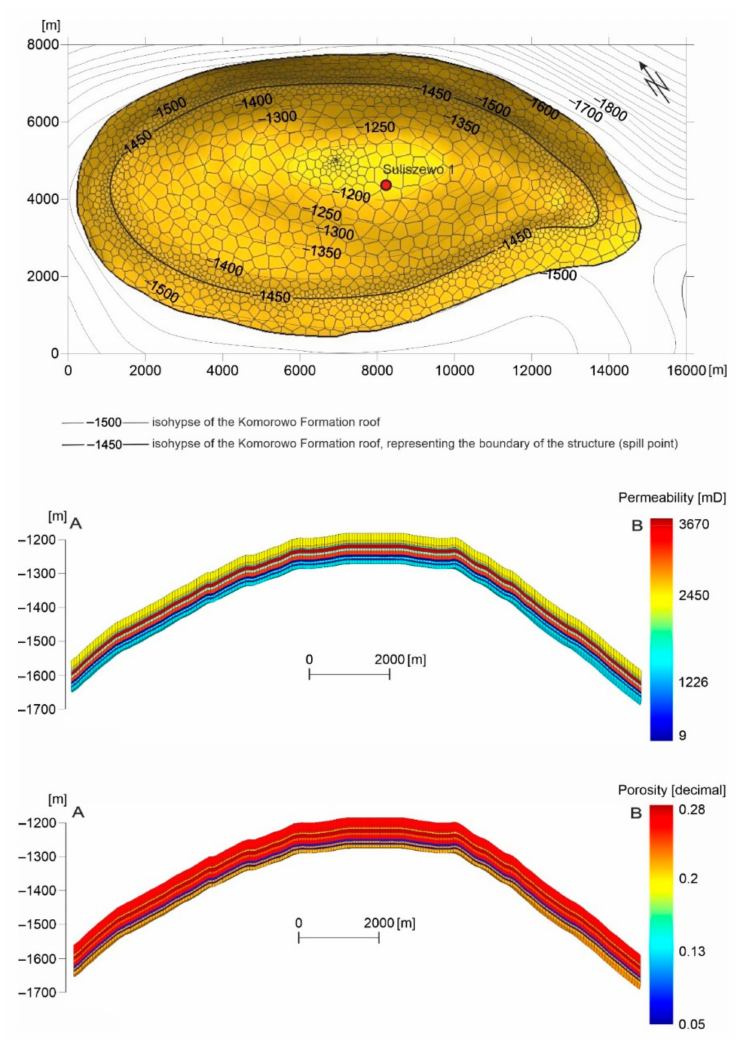
Figure 4. The area selected for modeling against the background of the Suliszewo structural map and the AB cross-sections of the reservoir, illustrating permeability and porosity changes (based on [52] with the author’s